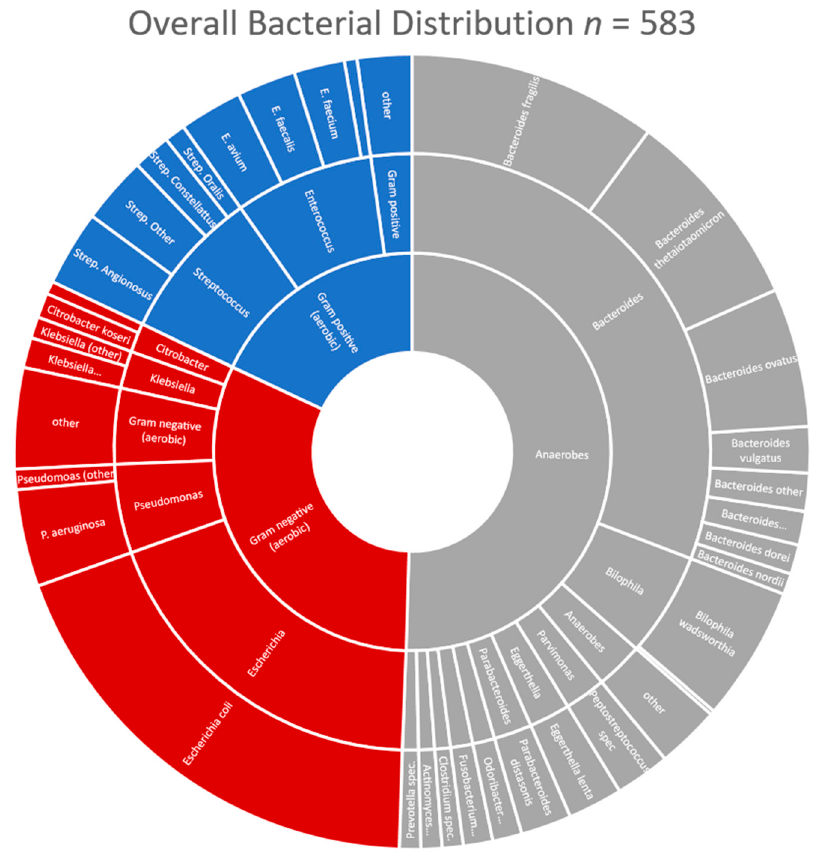
Figure 1. Overall Bacterial Distribution (strict anaerobes grey, Gram-negative bacteria red, Gram- positive blue).